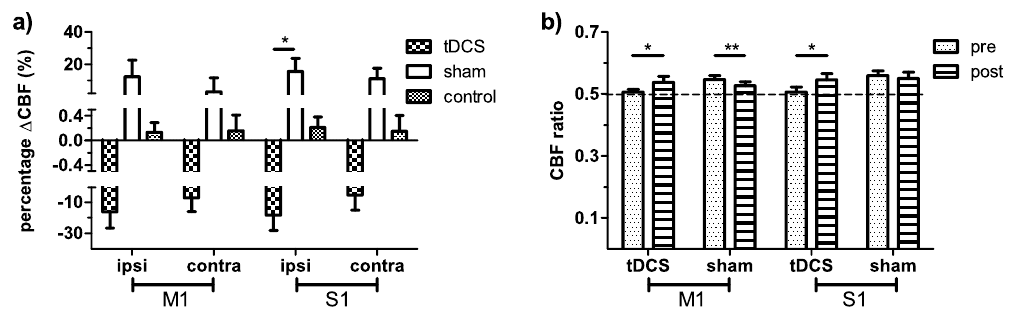
Figure 5. ROI analysis on CBF. ( a ) CBF in the primary motor (M1) and somatosensory (S1) cortices tends to be reduced after tDCS while increased after sham. Ipsi: ipsilesional side; contra: contralesional side. ( b ) The CBF asymmetry ratios in the primary motor and somatosensory cortices were increased after tDCS while decreased in the primary motor cortex in the sham group. For the control group, the change of CBF is the difference between the 2 scans. * p < 0.05; ** p < 0.01. Error bar represents